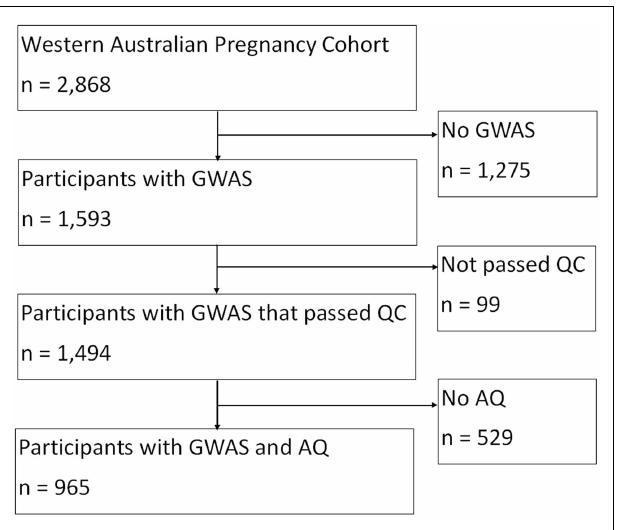
FIGURE 1 | Flow chart of study sample selection